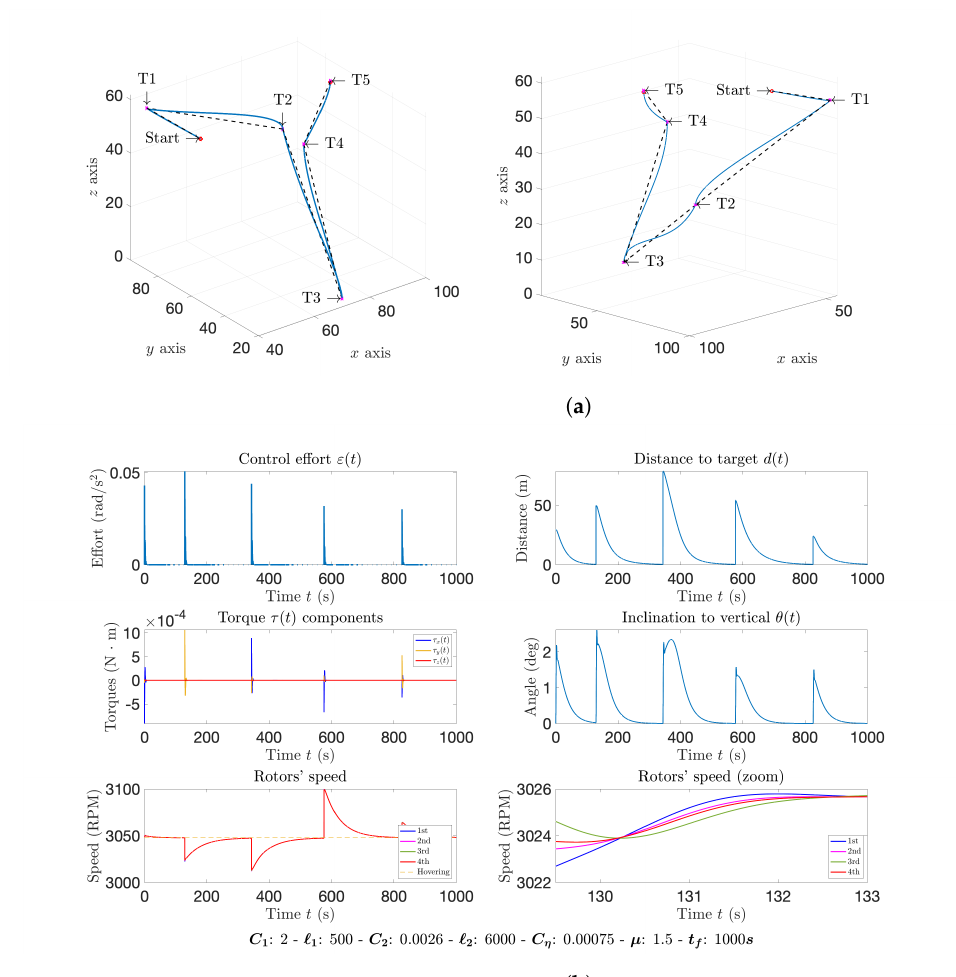
Figure 13. Experiment: Multiple shifting targets, first set of VARP parameters. In the target approaching plots, the dashed black lines represent the ideal trajectory which directly links the start point (current target) to the next target and all the targets have been labeled and marked by a magenta-colored cross. ( a ) Target approaching trajectory; ( b ) Control figures.